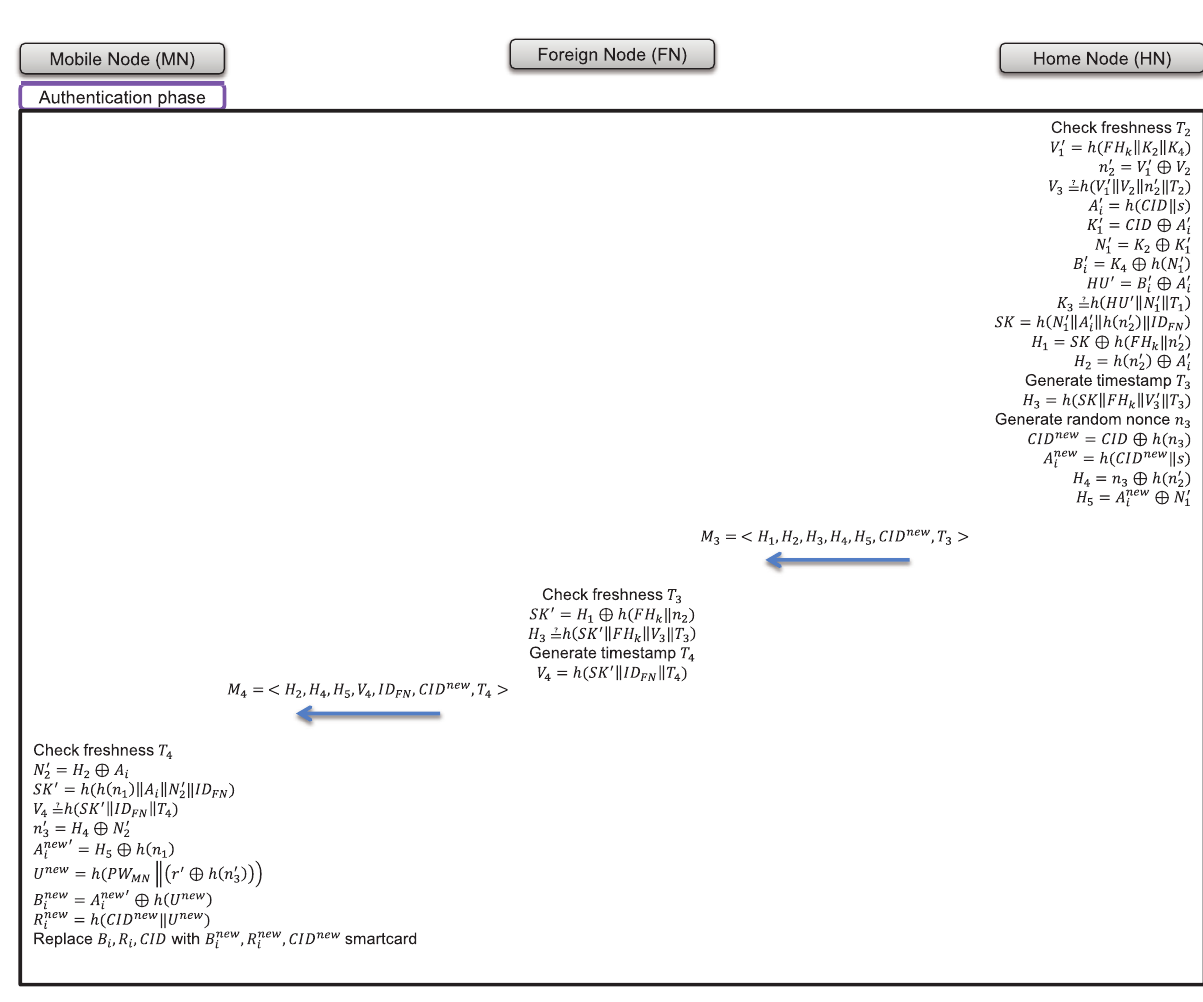
Fig 8. Authentication phase of proposed